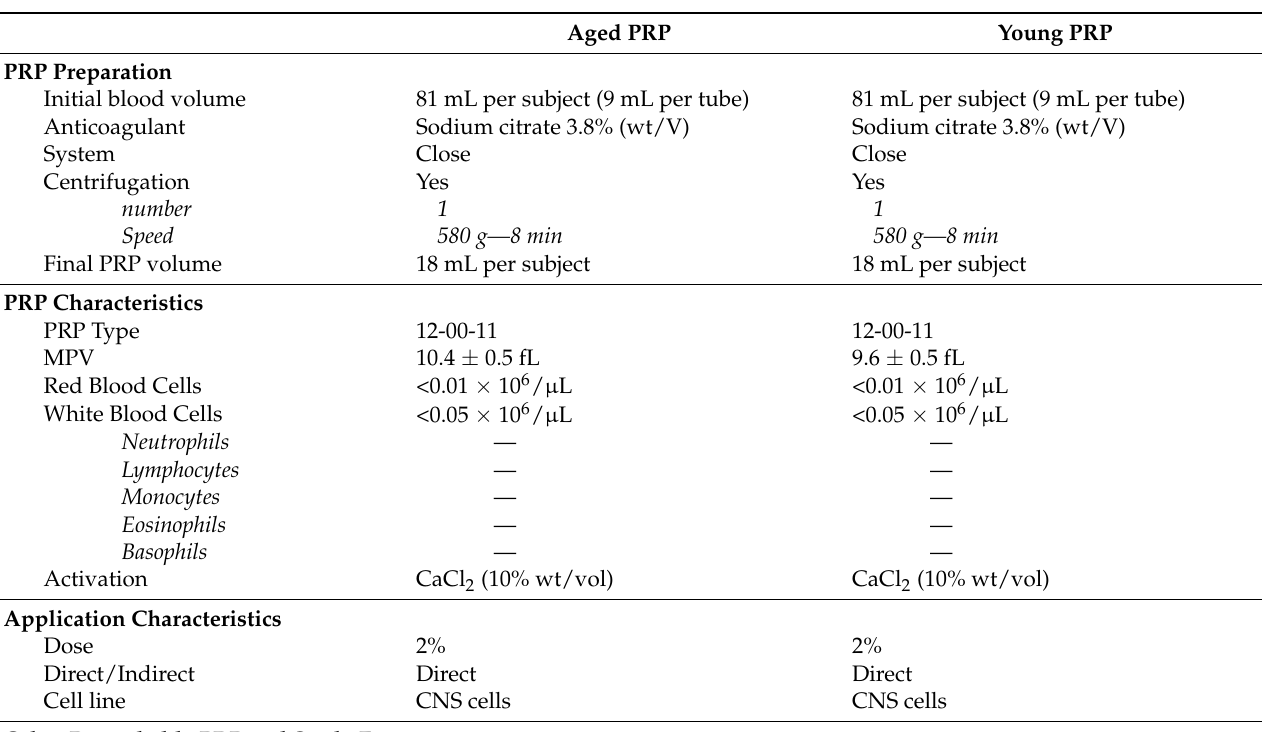
Table 2. Summary of characteristics for PRP.